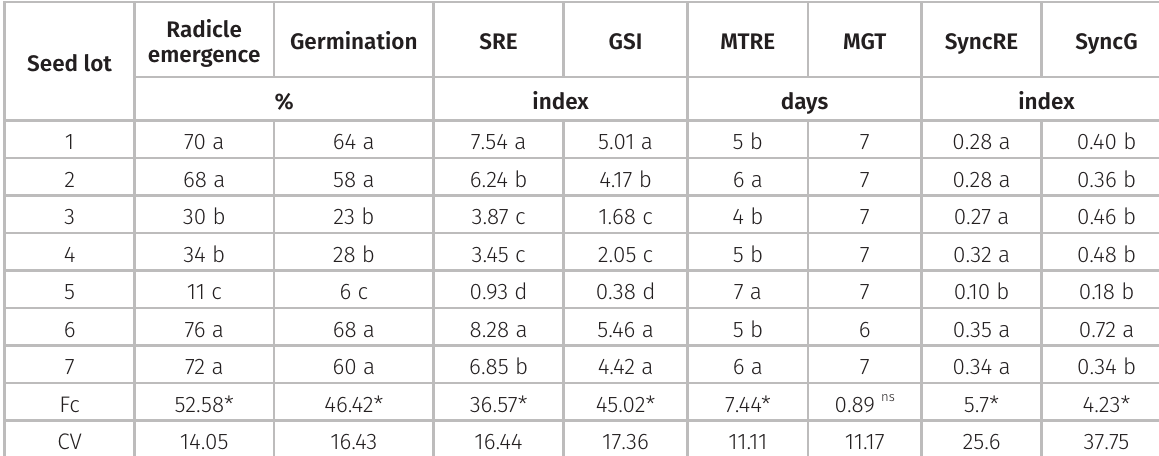
Table II. Mean values obtained for the physiological parameters obtained by the germination test of seven lots of Brachiaria ruziziensis